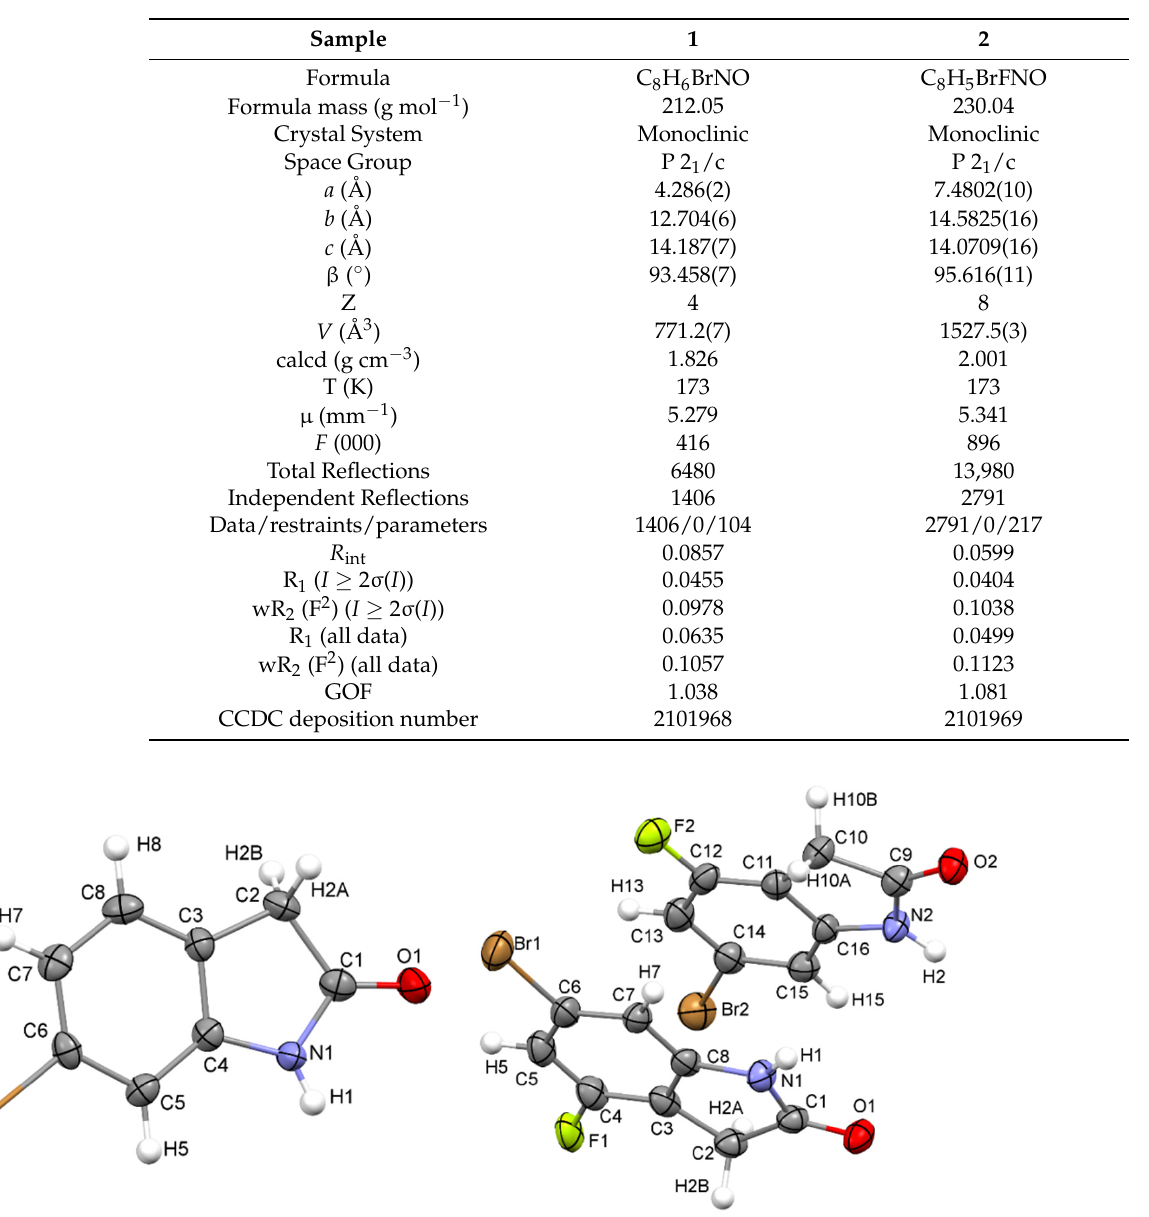
Table 1. X-ray Crystal data and refinement parameters for Structures 1 and 2 .